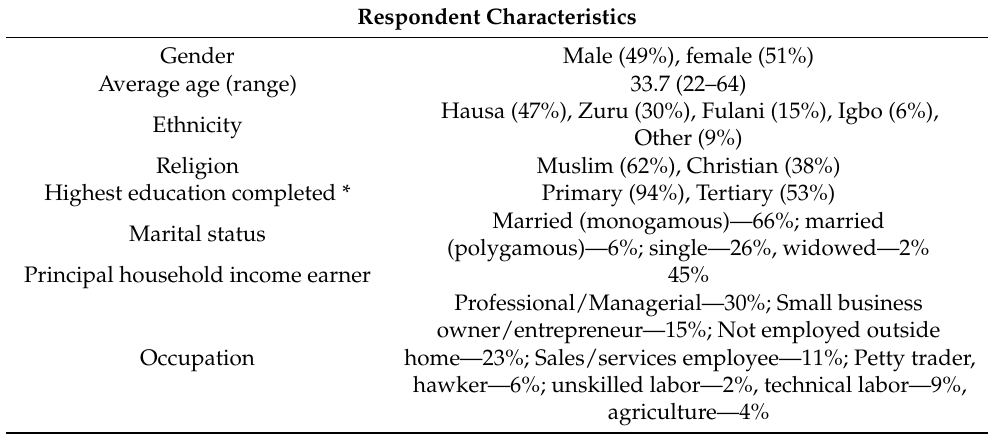
Table 1. Consumer demographic characteristics ( n =